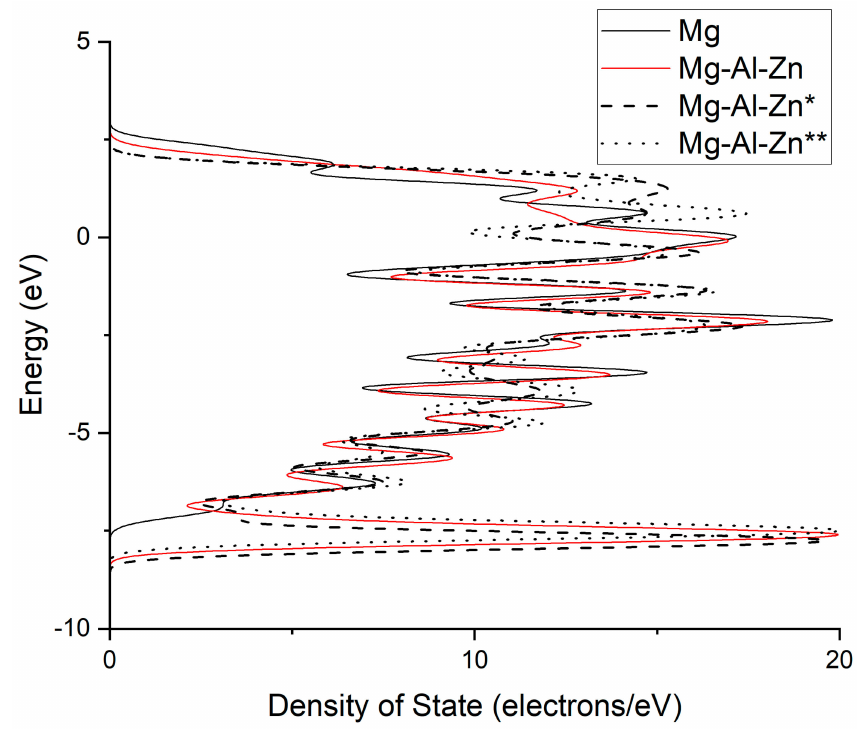
Figure 7. The density of states of Mg, Mg-Al-Zn, Mg-Al-Zn*, and Mg-Al-Zn**.